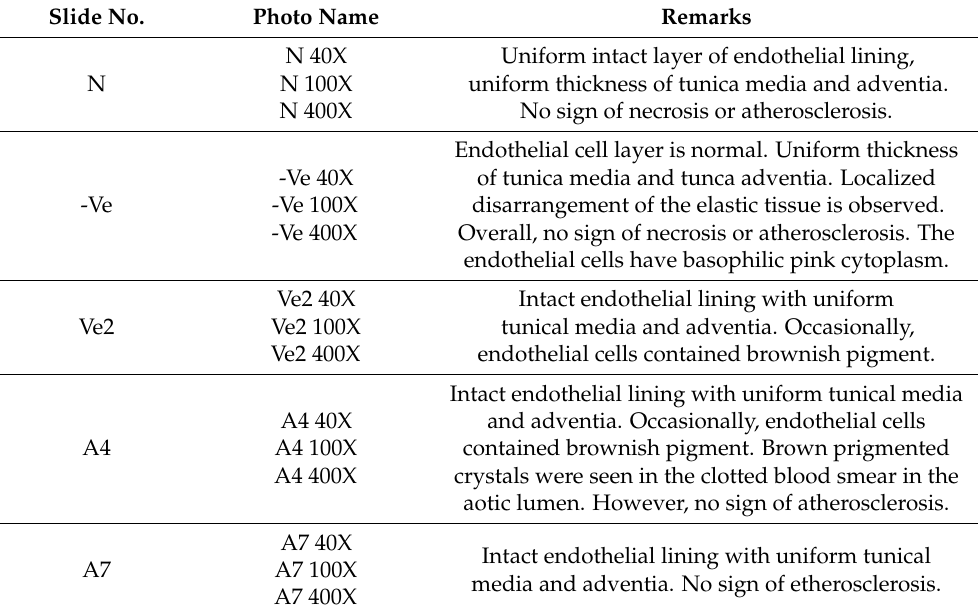
Table 8. Interpretation of aorta